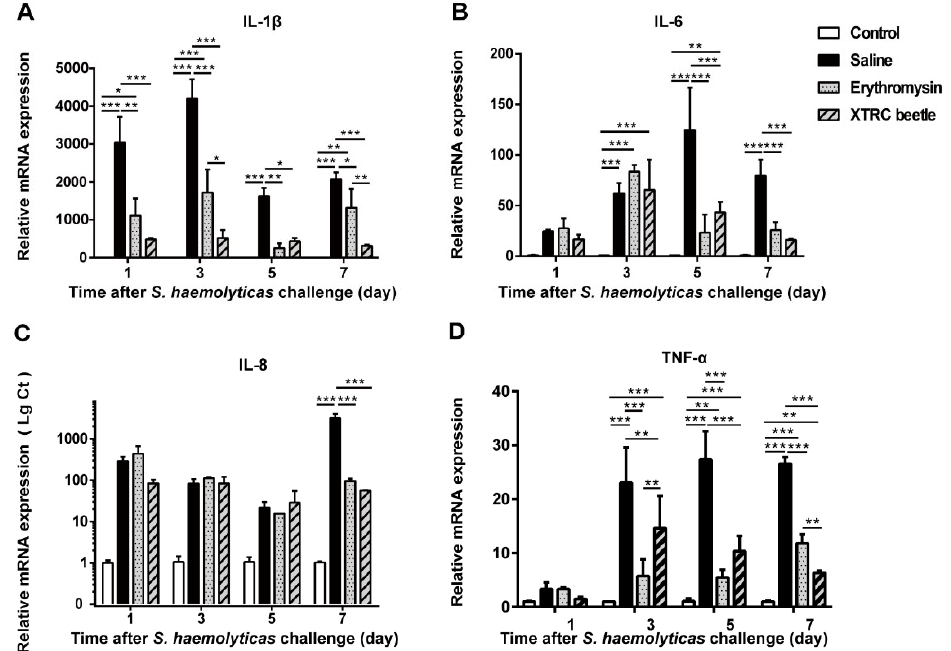
Figure 4. Effect of Z. morio hemolymph on the expression of IL-1 β , IL-6, IL-8, and TNF- α after thermal injury and infection in mice. ( A ) Real-time fluorescent quantitative polymerase chain reaction (PCR) was used to detect the expression of IL-1 β mRNA in the skin tissue of mice after thermal injury and infection. ( B ) Expression of IL-6 mRNA in skin tissue collected from mice after S. haemolyticus challenge was analyzed using quantitative real-time PCR. ( C ) Relative expression of chemokine IL-8 in normal control, saline, erythromycin ointment and Z. morio hemolymph groups. ( D ) Relative expression of TNF- α in wound skin tissue of thermally injured and infected mice after various treatments. All data are presented as mean ± standard deviation of the mean (SEM), * p < 0.05; ** p < 0.01; *** p < 0.001, n = 4.